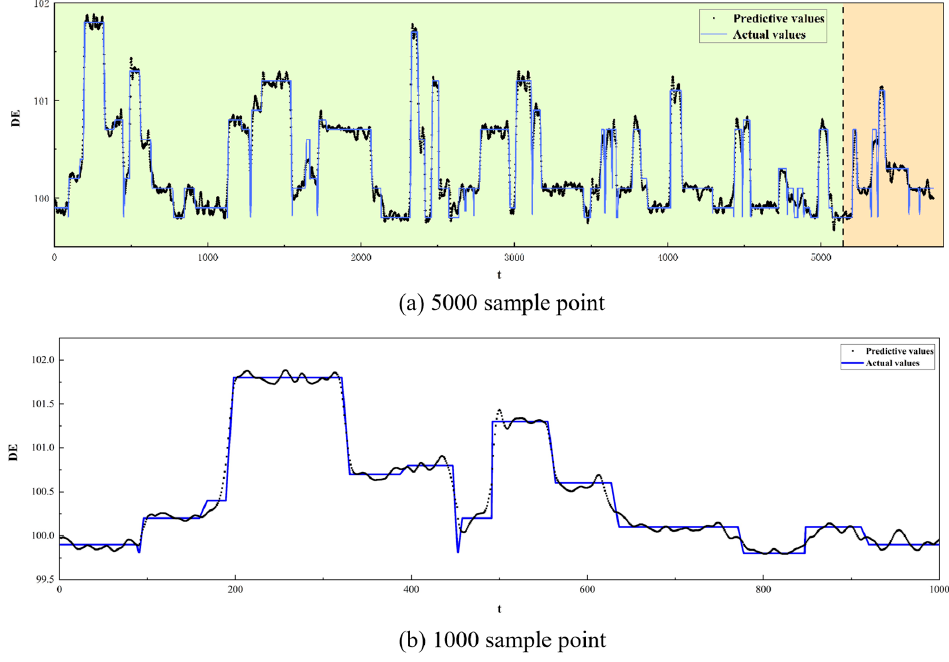
Figure 8. Comparison of actual and predicted values of DE values.